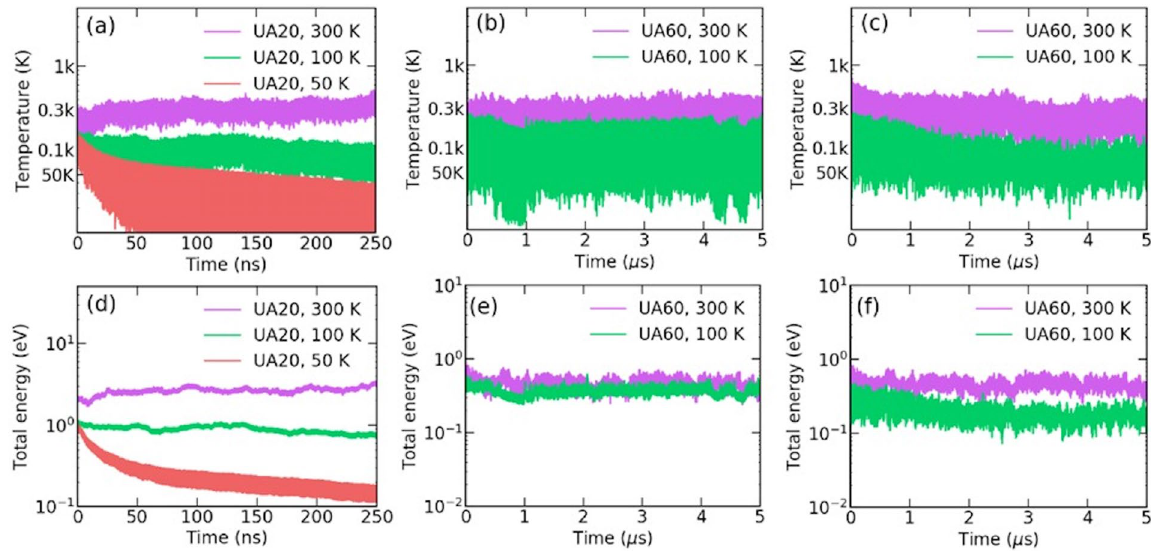
Figure 5. Temperature and total energy of the strain CGMD simulation without external thermostatting at 50, 100 and 300 K shown by red, green and magenta lines, respectively: ( a ) and ( d ) UA20 with rigid boundary, ( b ) and ( e ) UA60 with a 0 K rigid boundary, ( c ) and ( f ) UA60 with LJ potential fixation with ε = 1 eV for 300 K and 1 eV for 100